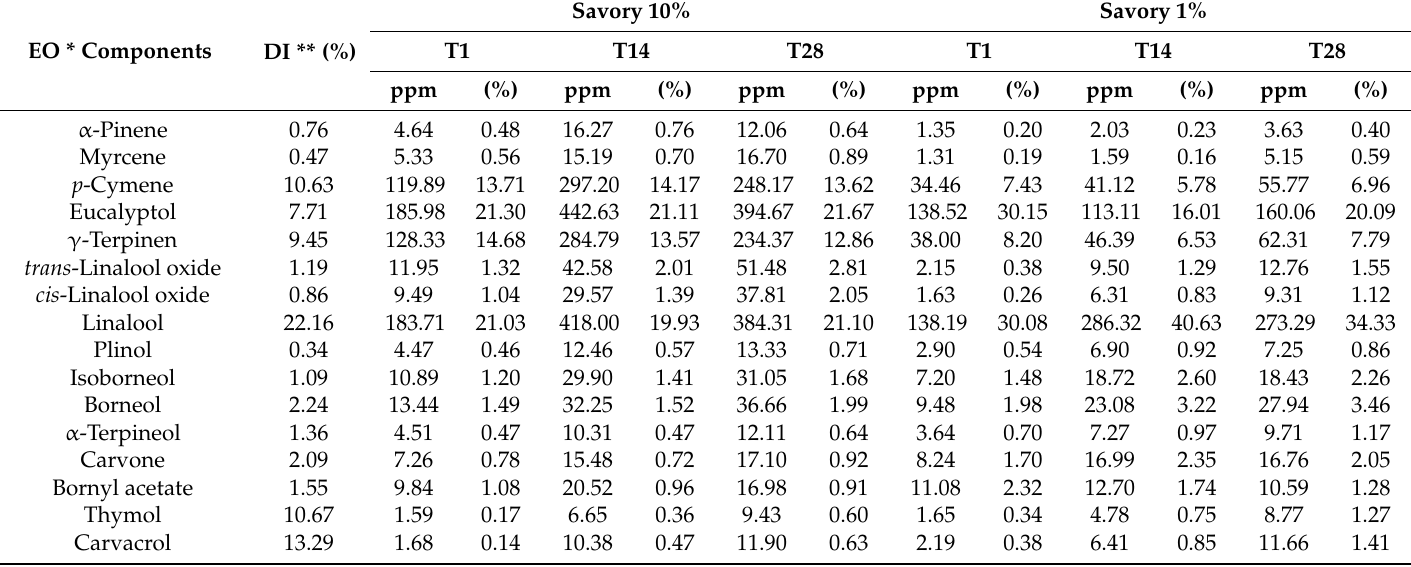
Table 3. Savory essential oil composition and volatilized compounds in storage cabinet at 1, 14 and 28